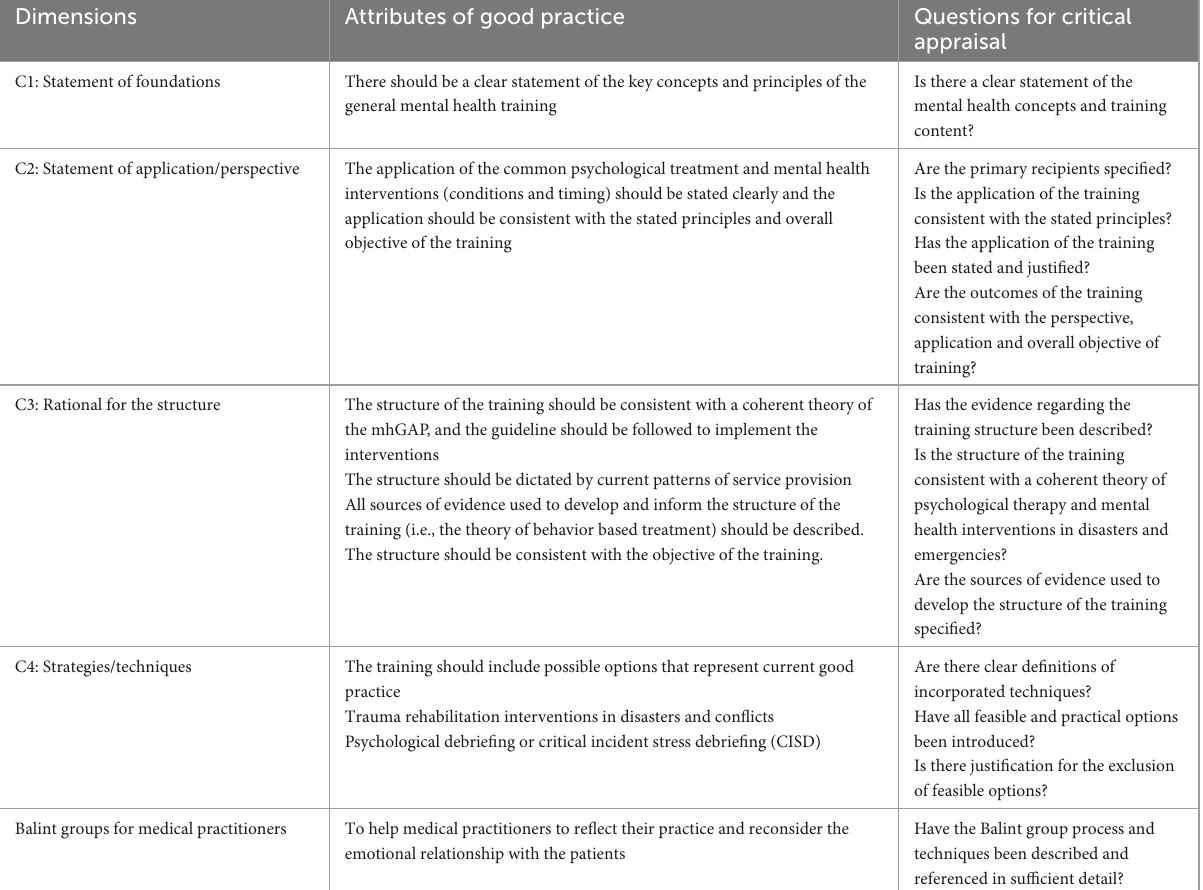
TABLE 2 Fidelity checklist (Control